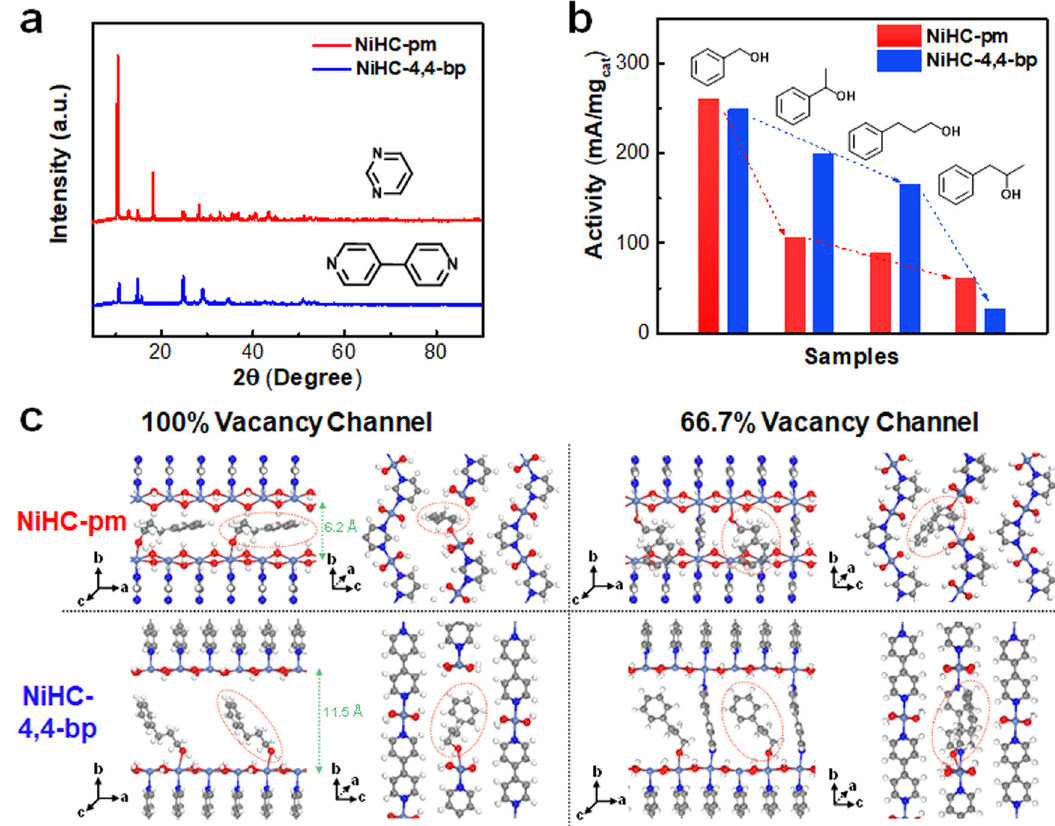
Fig. 5 | Tunable channels for size-selective electrochemical oxidation. a The PXRD patterns of the NiHC-pm and NiHC-4,4-bp. b The gravimetric current den- sities of NiHC-pm and NiHC-4,4-bp at 1.47V vs . RHE in 1M KOH+0.1M substrates